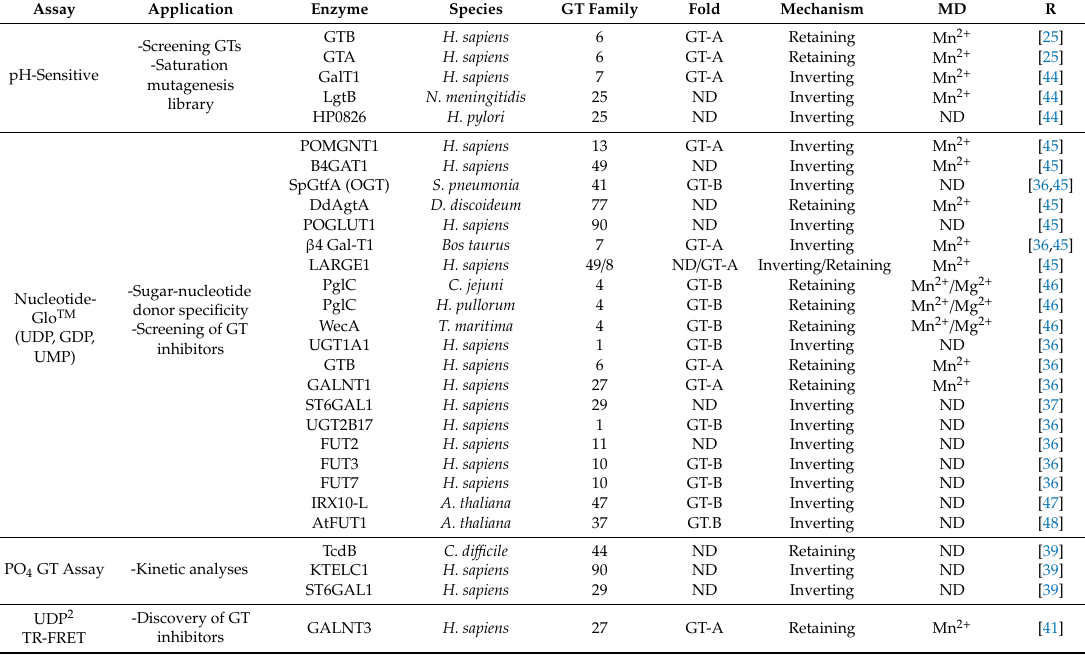
Table 1. Application examples of the investigated assays in previous studies. ND, not determined; MD, metal-dependence; R,